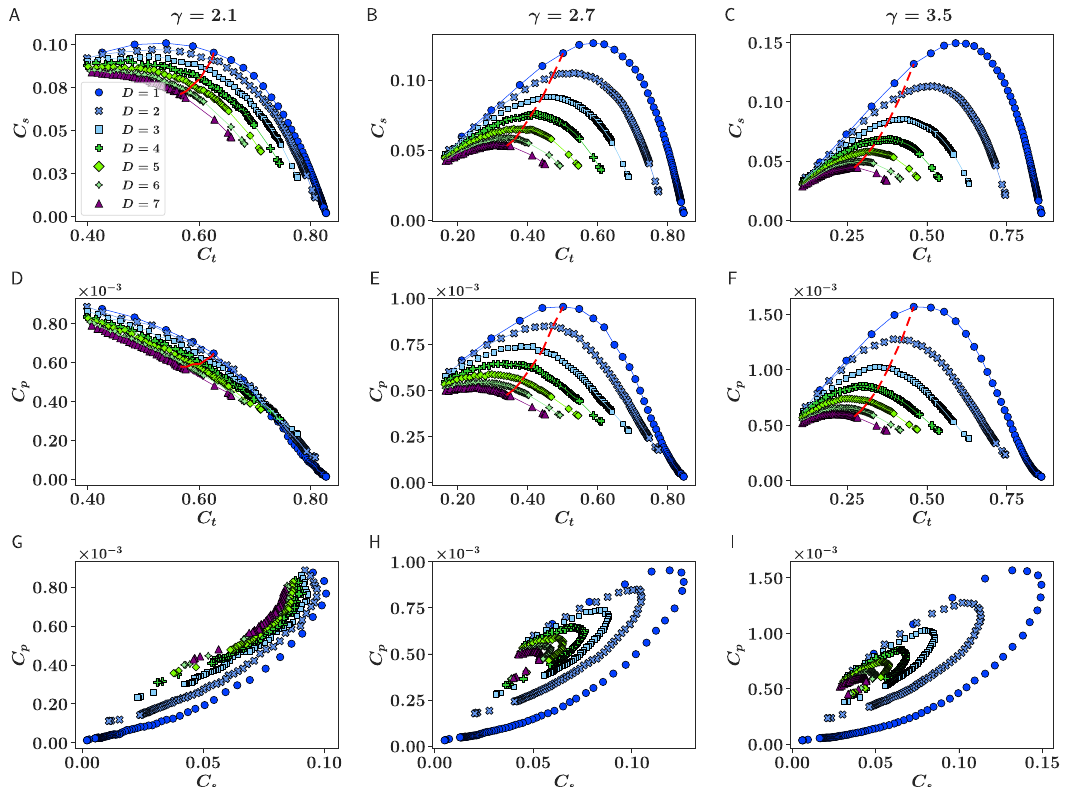
Fig.2|Relationbetweendensitiesofedgetriangles,squaresandpentagonsfor different values of γ . Panels ( A – C ) show the projection of the phase space in the subspace ( C s , C t ), panels ( D – F ) show the projection in the subspace ( C p , C t ), and panels( G – I )showtheprojectioninthesubspace( C p , C s ).Inplots( A – F ),thedashed red line represents the β =2 D limit separating the small-world and large-world